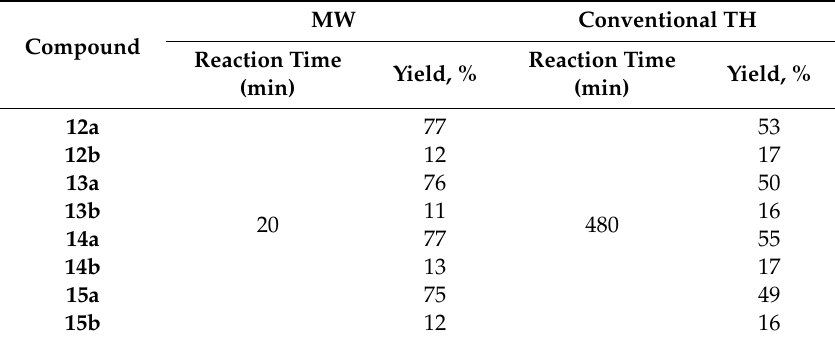
Table 3. Synthesis of α -brominated pyrrolodiazine, under MW and TH conditions. MW Conventional TH Compound Reaction Time Reaction Time Yield, Yield, % (min) (min)